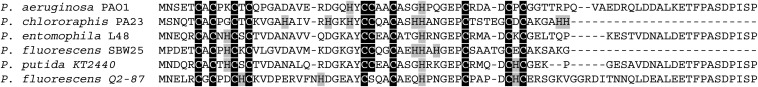
Pseudomonas MTs. Amino acid sequences alignment of MTs from different Pseudomonas species. Cys residues are highlighted in black, His residues in gray.